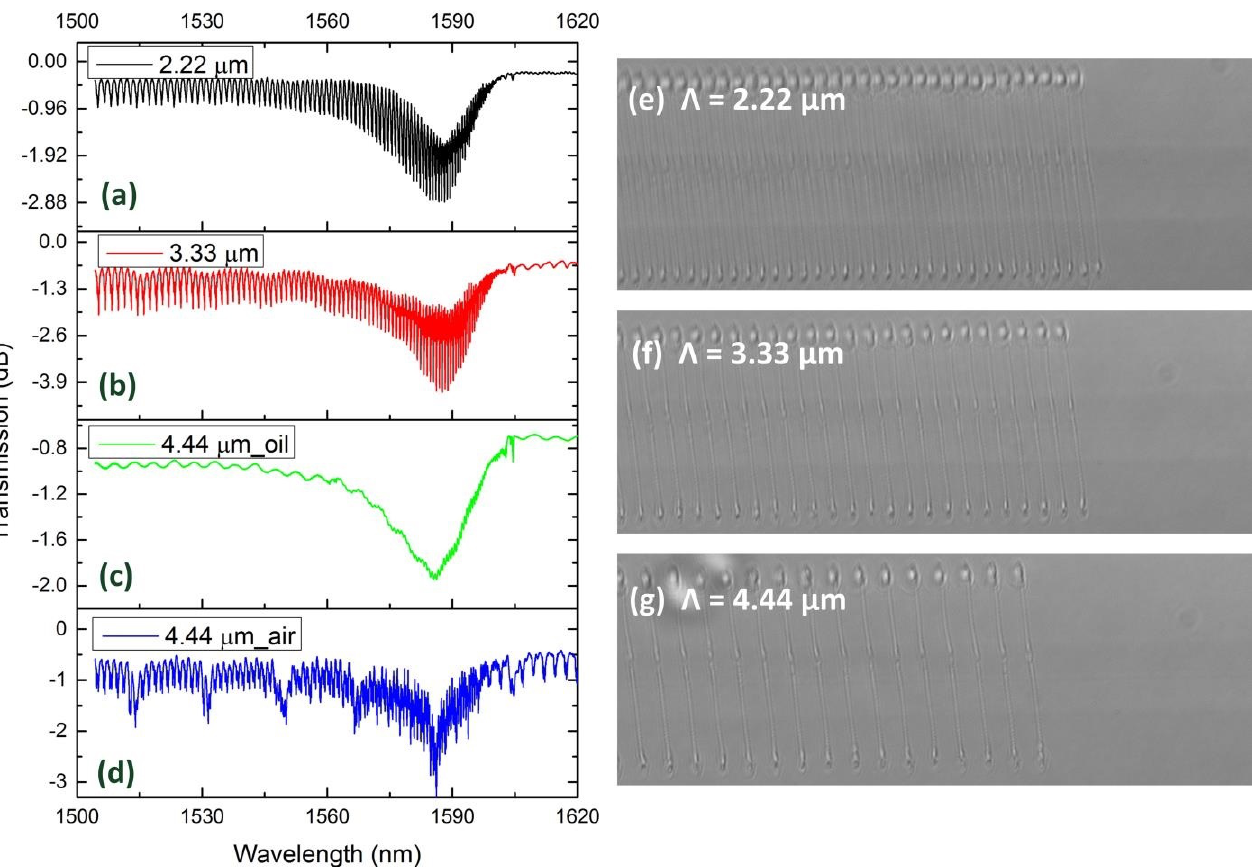
Figure 10. Spectra of 6°TFBGs with different harmonic order: ( a ) Λ = 2.22 μm, ( b ) Λ = 3.33 μm, ( c ) Λ = 4.44 μm (in oil), and ( d ) Λ = 4.44 μm (in air). Microscopy image (100×): ( e ) Λ = 2.22 μm, ( f ) Λ = 3.33 μm, and ( g ) Λ = 4.44 μm.